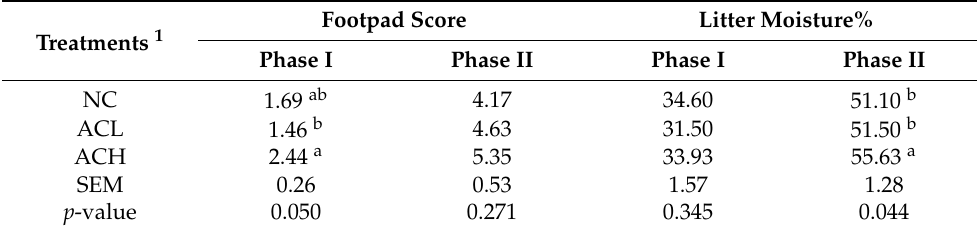
Table 5. Effect of different levels of aging corn on litter moisture and foot-pad dermatitis score in the